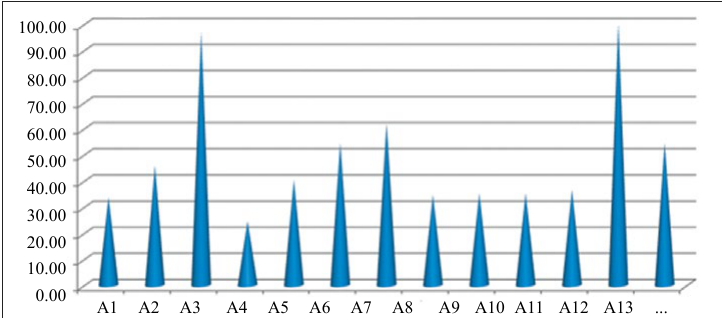
Fig. 5. The utility degrees of alternatives obtained by AHP-COPRAS (Case 3)